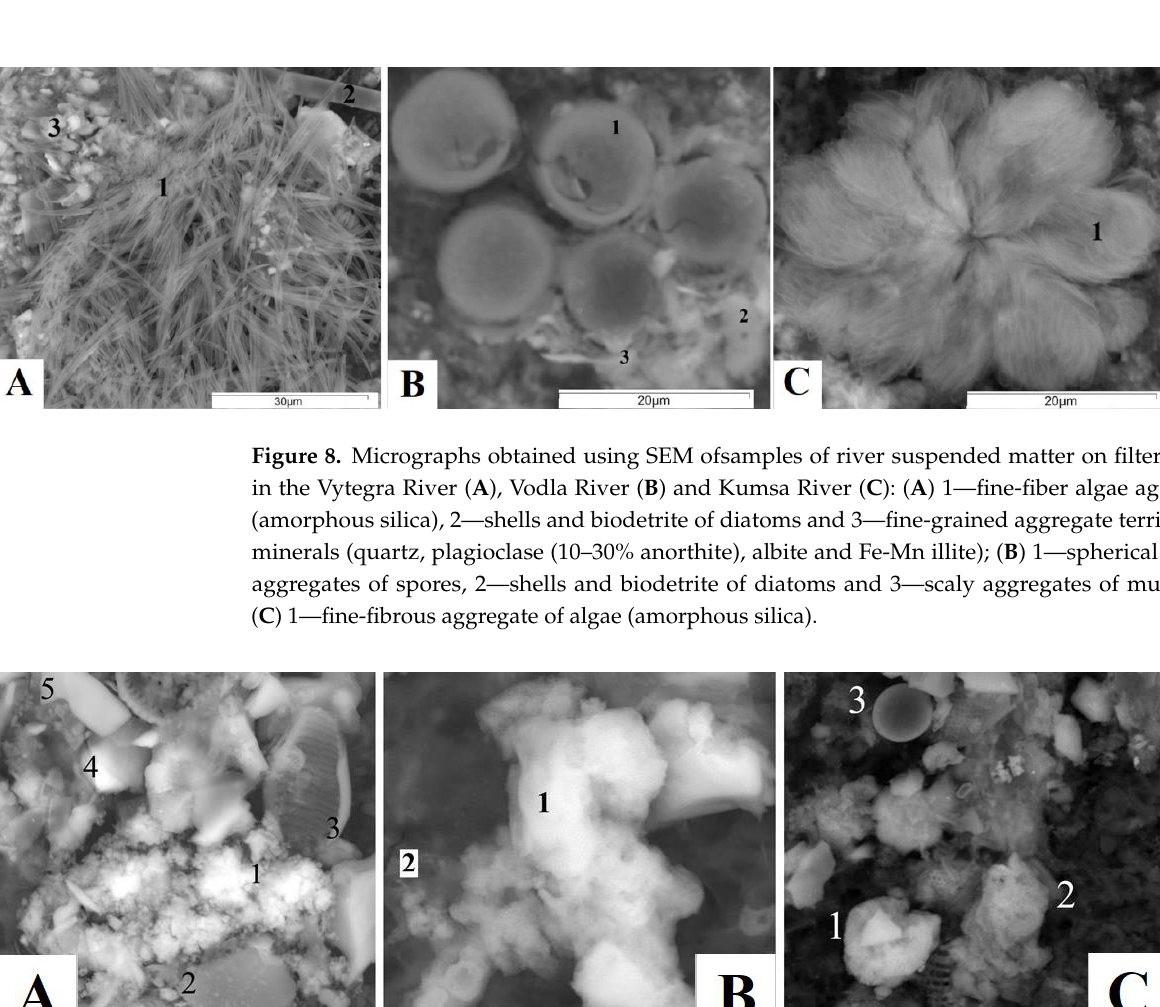
Figure 9. Micrographs made using SEM of the aggregates of manganese minerals in river suspended matter on filters taken in the Sheltozerka River ( A ), Vytegra River ( B ) and Lososinka River ( C ): ( A ) 1—earthy aggregates of rhodochrosite, 2—quartz, 3—shells and biodetrite of diatoms, 4—Fe-Mn illite and 5—albite; ( B ) 1,2—sintering aggregates of Mn oxides and hydroxides of varying degrees of crystallinity; ( C ) 1—sintering aggregates of Mn oxides and hydroxides with an admixture of Ba (up to 4%), 2—earthy aggregates of Fe and Mn oxides and hydroxides with an admixture of Ba (1%) and P (1%) and 3—shells and biodetrite of